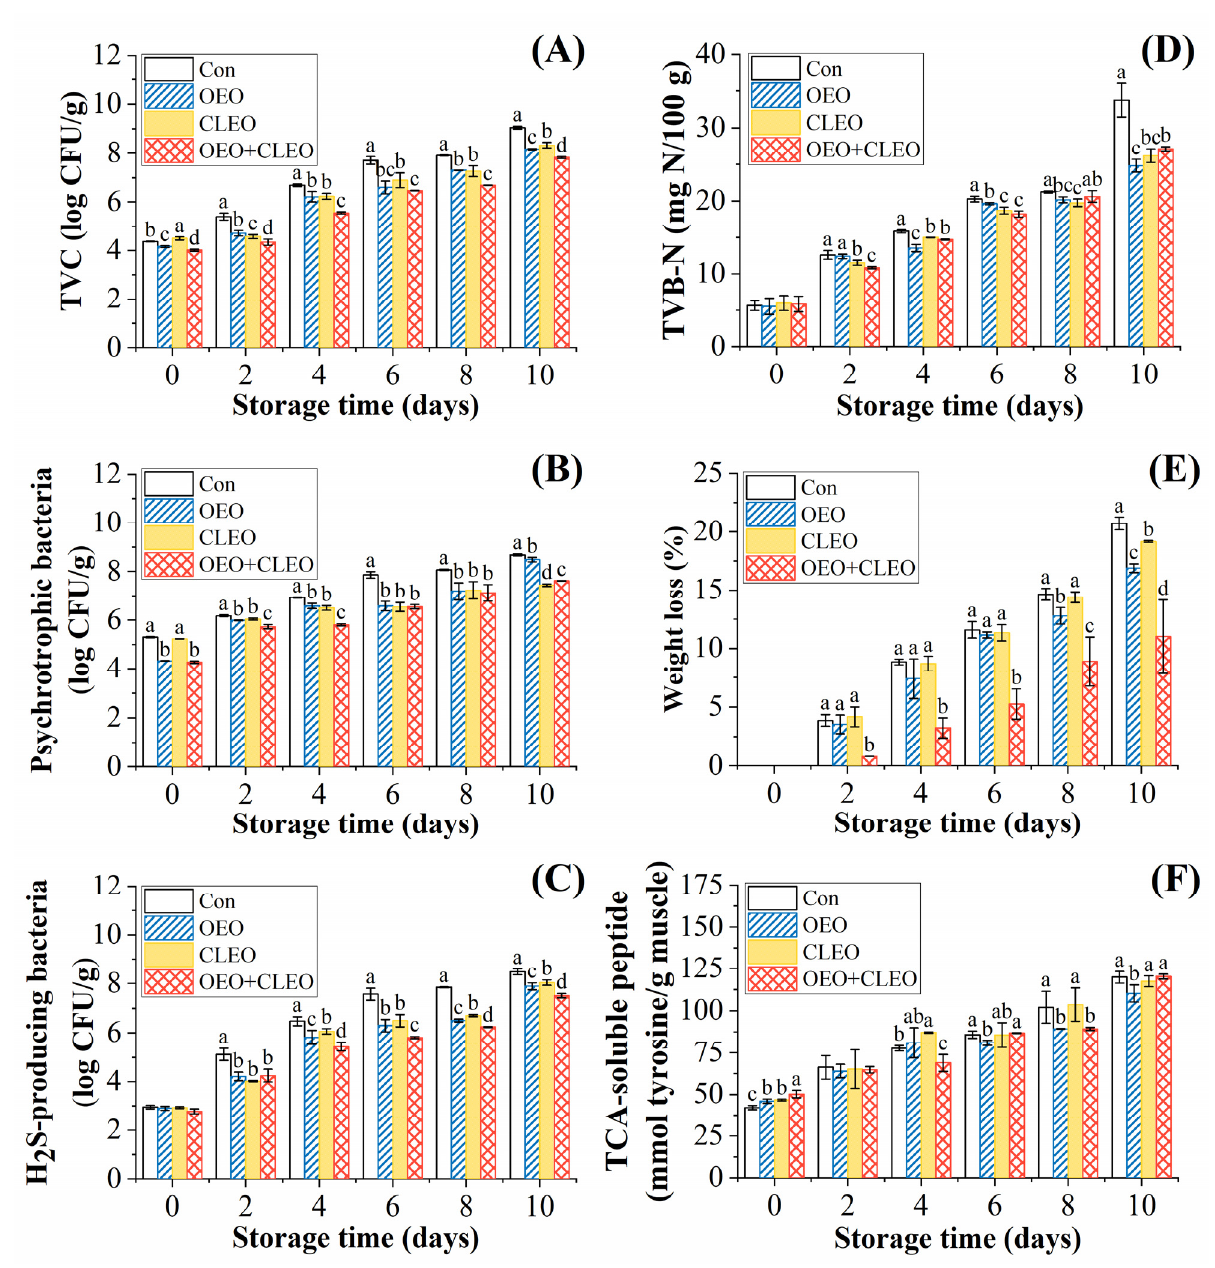
Figure 1. Changes of total viable counts ( A ), psychrotrophic bacterial counts ( B ), H 2 S-producing bacterial counts ( C ), TVB-N ( D ), weight loss ( E ) and TCA-soluble peptide ( F ) of refrigerated Pacific white shrimp treated with OEO and CLEO at 4 ◦ C. Data are shown as mean ± SD (n = 3). Note: Different lowercase letters indicate significant differences ( p < 0.05) among different treatments within the same storage